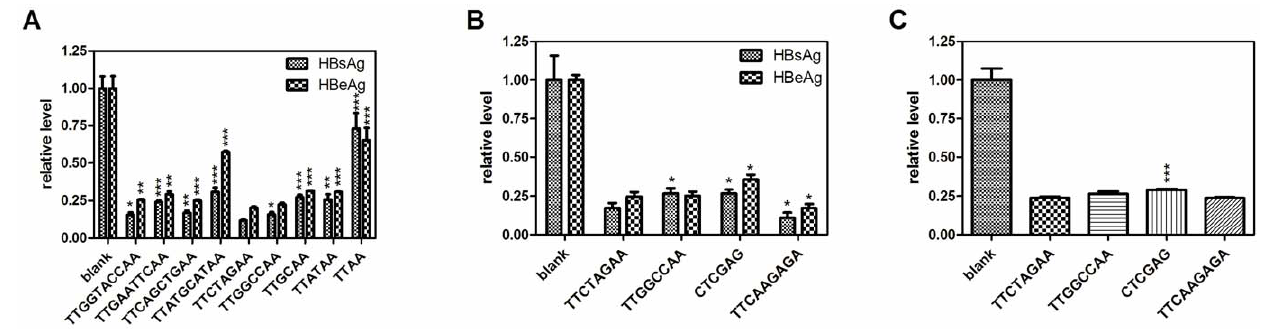
Figure 2. The effects of various loop sequences on shRNA silencing activity. (A) An shRNA scaffold targeted to the HBV conserved sequence ‘‘GGUAUGUUGCCCGUUUGUCCU’’ reported previously was selected and designed as an antisense-loop-sense structure (AS). (B) (C) The two best loops were selected and compared with two well-known loops TTCAAGAGA (used in pSuper) and CTCGAG (used in pLKO.1-puro) for two irrelevant target depression. The HBV target sequence ‘‘GGUAUGUUGCCCGUUUGUCCU’’ and the Gluc target sequence ‘‘UCUGUUUGCCCUGAUCUGCAU’’ were used in (B) and (C) respectively. Statistical significance was determined respectively by comparing shRNAs groups with that containing ‘‘TTCTAGAA’’ loop. Means and standard deviations were generated from 3 independent experiments. The ‘‘blank’’ group represents cells treated with pshOK-basic instead of the shRNA plasmid. The value in the blank group was set at 1.0.